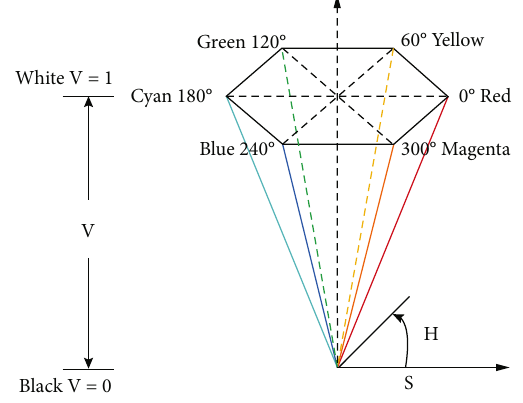
Figure 5: Hue, saturation, and value color space model structure